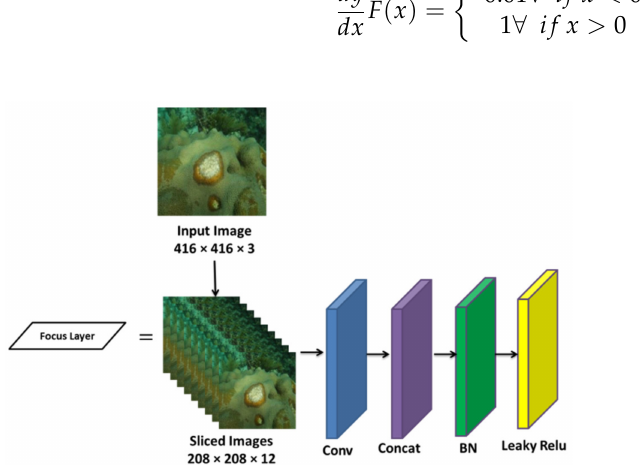
Figure 3. Architecture of the focus